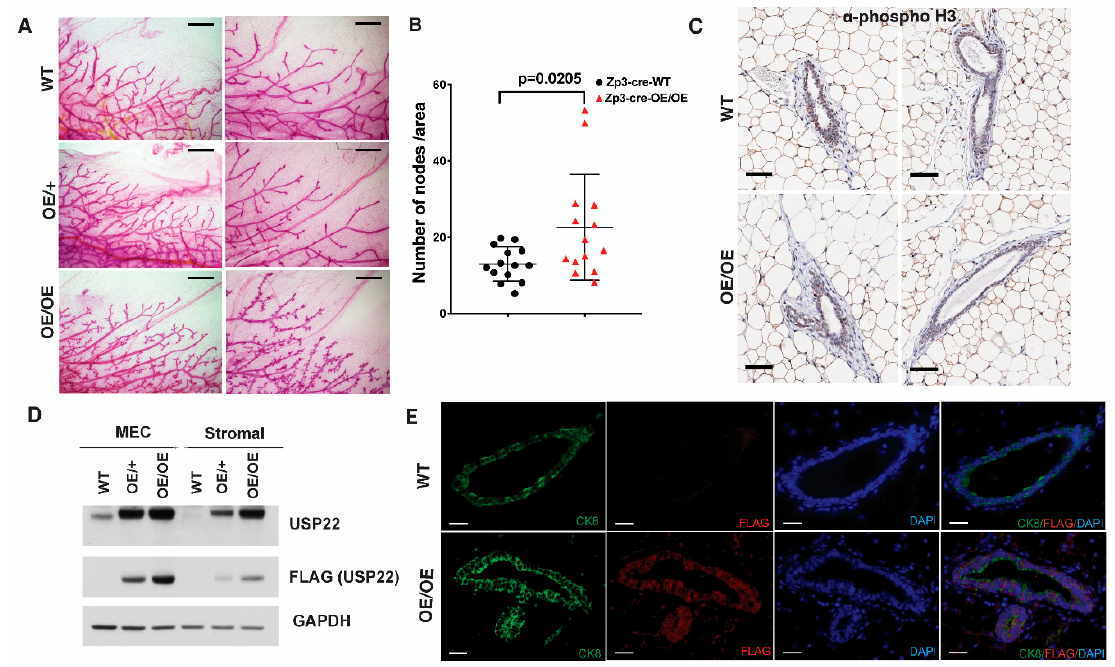
Figure 2. Usp22 ubiquitous overexpression induces mammary gland over branching in post-pubertal nulliparous mice. ( A ) Mammary glands from nulliparous females at 16 weeks were stained with carmine alum. Representative images of mammary gland trees from wild type, heterozygous OE/+, and homozygous OE/OE female mice are shown. Scale bar—2 mm. ( B ) Quantification of mammary gland branching by counting the total number of branch nodes found in ¼ of the branching area from the lymph node to the ending point in each genotype (n = 14) and normalized as numbers of nodes per 6 × 10 6 μ m 2 areas. p value was calculated with unpaired t test. ( C ) Anti-phospho histone H3 immunostaining of mammary gland paraffin sections from 16-week-old wild type and OE/OE nulliparous females show no overt increase in cell proliferation. Scale bar—150 µ m. ( D ) Representative immunoblots using whole cell extracts from primary MECs and stromal fibroblasts from 3.5-month-old wild type, Usp22 OE/+ or Usp22 OE/OE female mammary glands to validate the overexpression of Usp22 . ( E ) Immunostaining of mammary gland paraffin sections with anti-FLAG and anti-CK8 antibodies confirm the expression of Usp22 in both epithelial and stromal cells. Scale bar—50 μ m.